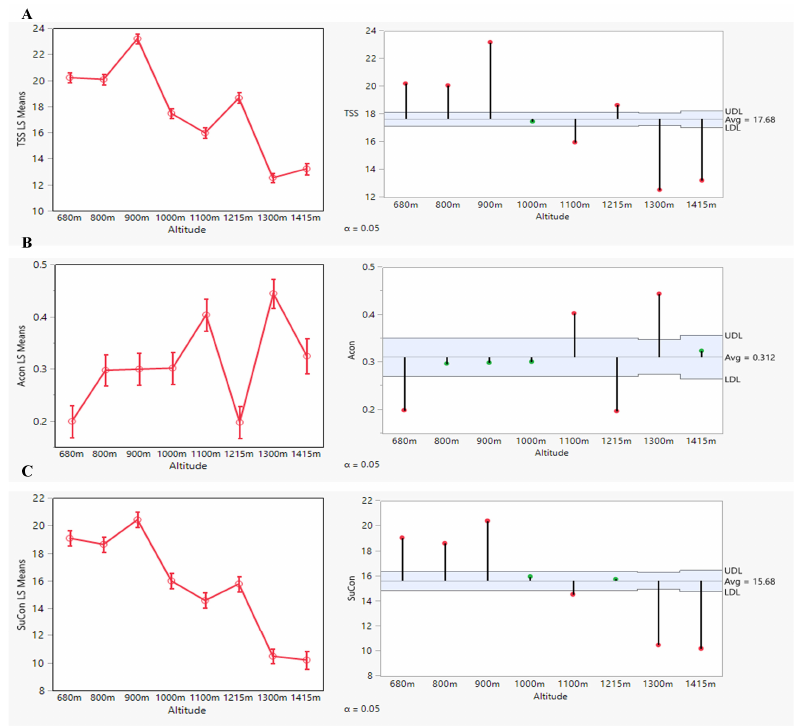
Figure 3. The least-square means for quality parameters (left: least square means; right: comparison with average), including: ( A ) Total soluble solids (TSS); ( B ) Total acid (Acon LS); and ( C ) Total sugar (SuCon). 3.2. Characterization of Volatile Compounds Changes in volatiles composition could induce alterations in flavor and aroma. To comprehend the effect of increasing altitudes on aromatic compounds, we characterized dried fruit, pericarp, and sarcocarp tissues for available volatiles. The accumulation pat- tern of volatile compounds in the three tissues was highly differentiated, with no obvious accumulation pattern between different altitudes. As a result, we identified a total of 104 volatile compounds at least accumulated in one tissue (dried fruit, pericarp, and/or sarco- carp) (Table S2). Volatile compounds, including alpha-Guaiene, beta-Ocimene, 136-Octatriene, 37-di- methyl-(Z)-246-Octatriene, 26-dimethyl-(EZ), 26-Dimethyl-1357-octatetraene-EE, Az-